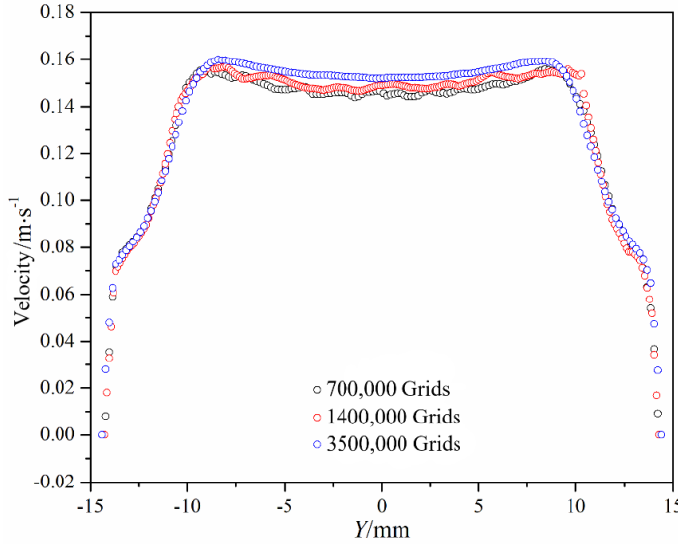
Figure 3. Velocity distribution with different kinds of mesh regimes.